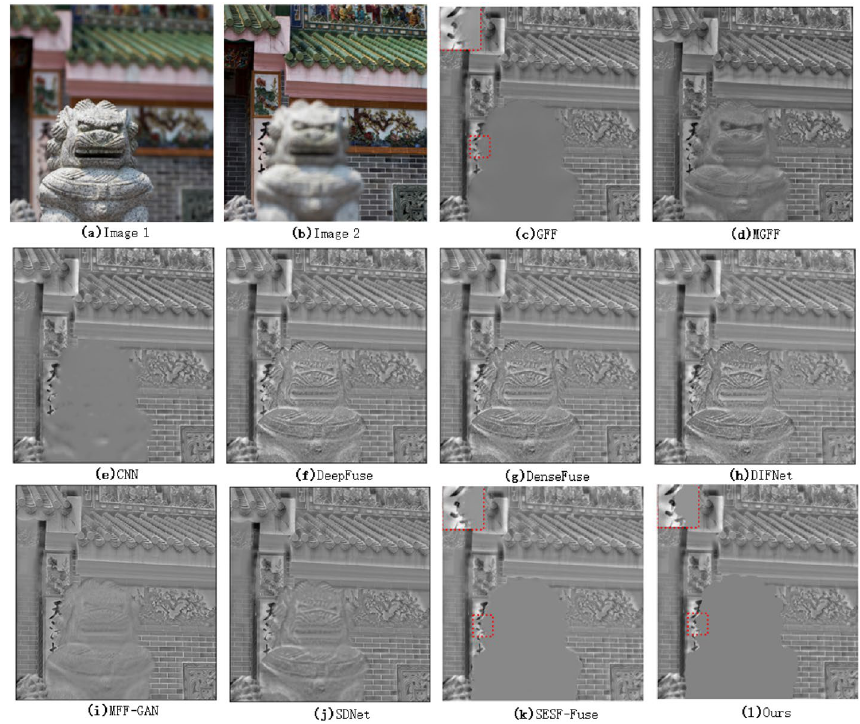
Figure 6. Comparison of difference between fused image and original image 2(Savic temple 36